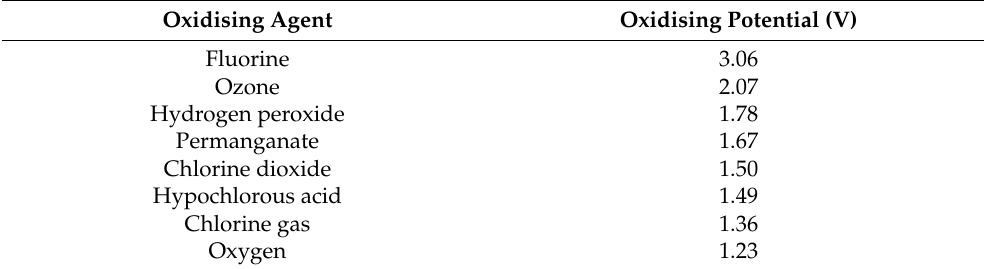
Table 2. Oxidising agents and their oxidation potential